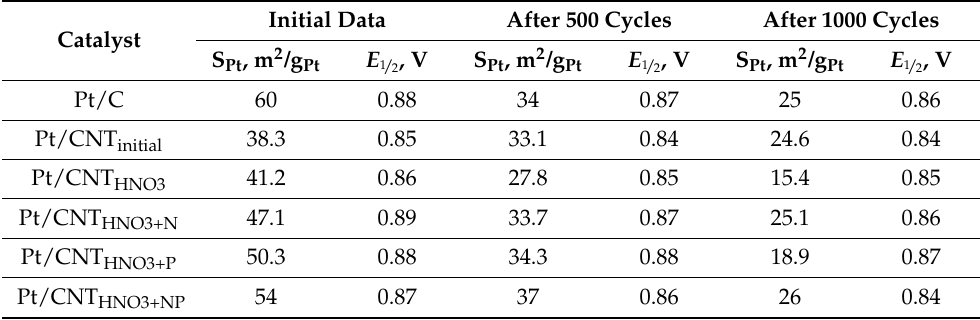
Table 5. The electrochemical parameters changes of Pt catalysts during accelerated corrosion testing.